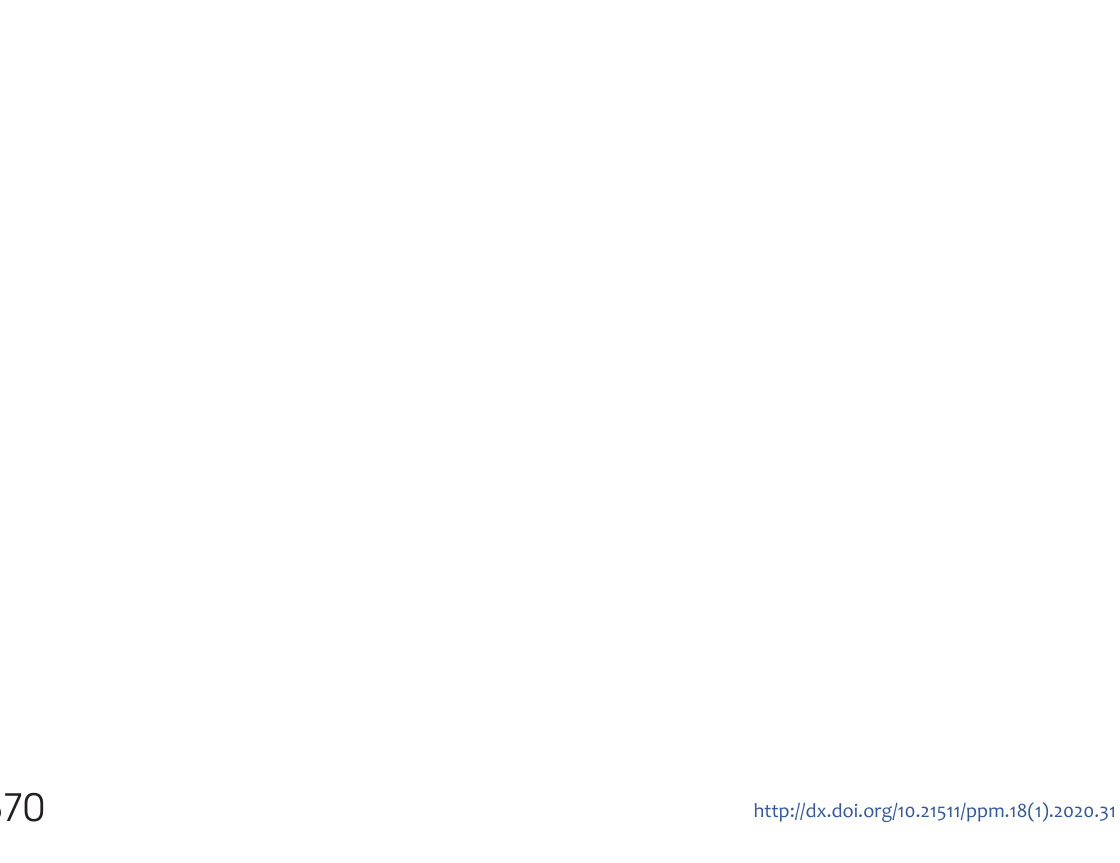
Table A1. Top-100 latifundists in Ukraine as of January 1, 2020